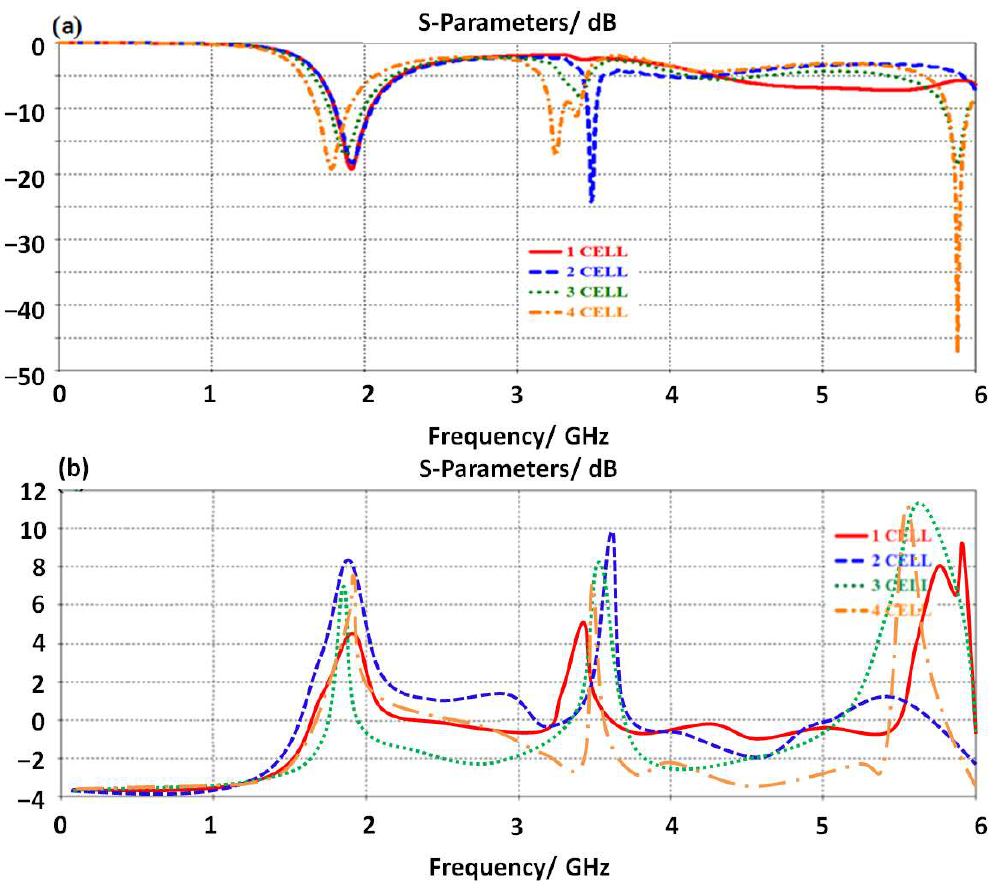
Figure 3. Antenna performance with different cell numbers: (a) S 11 spectra and (b) gain.